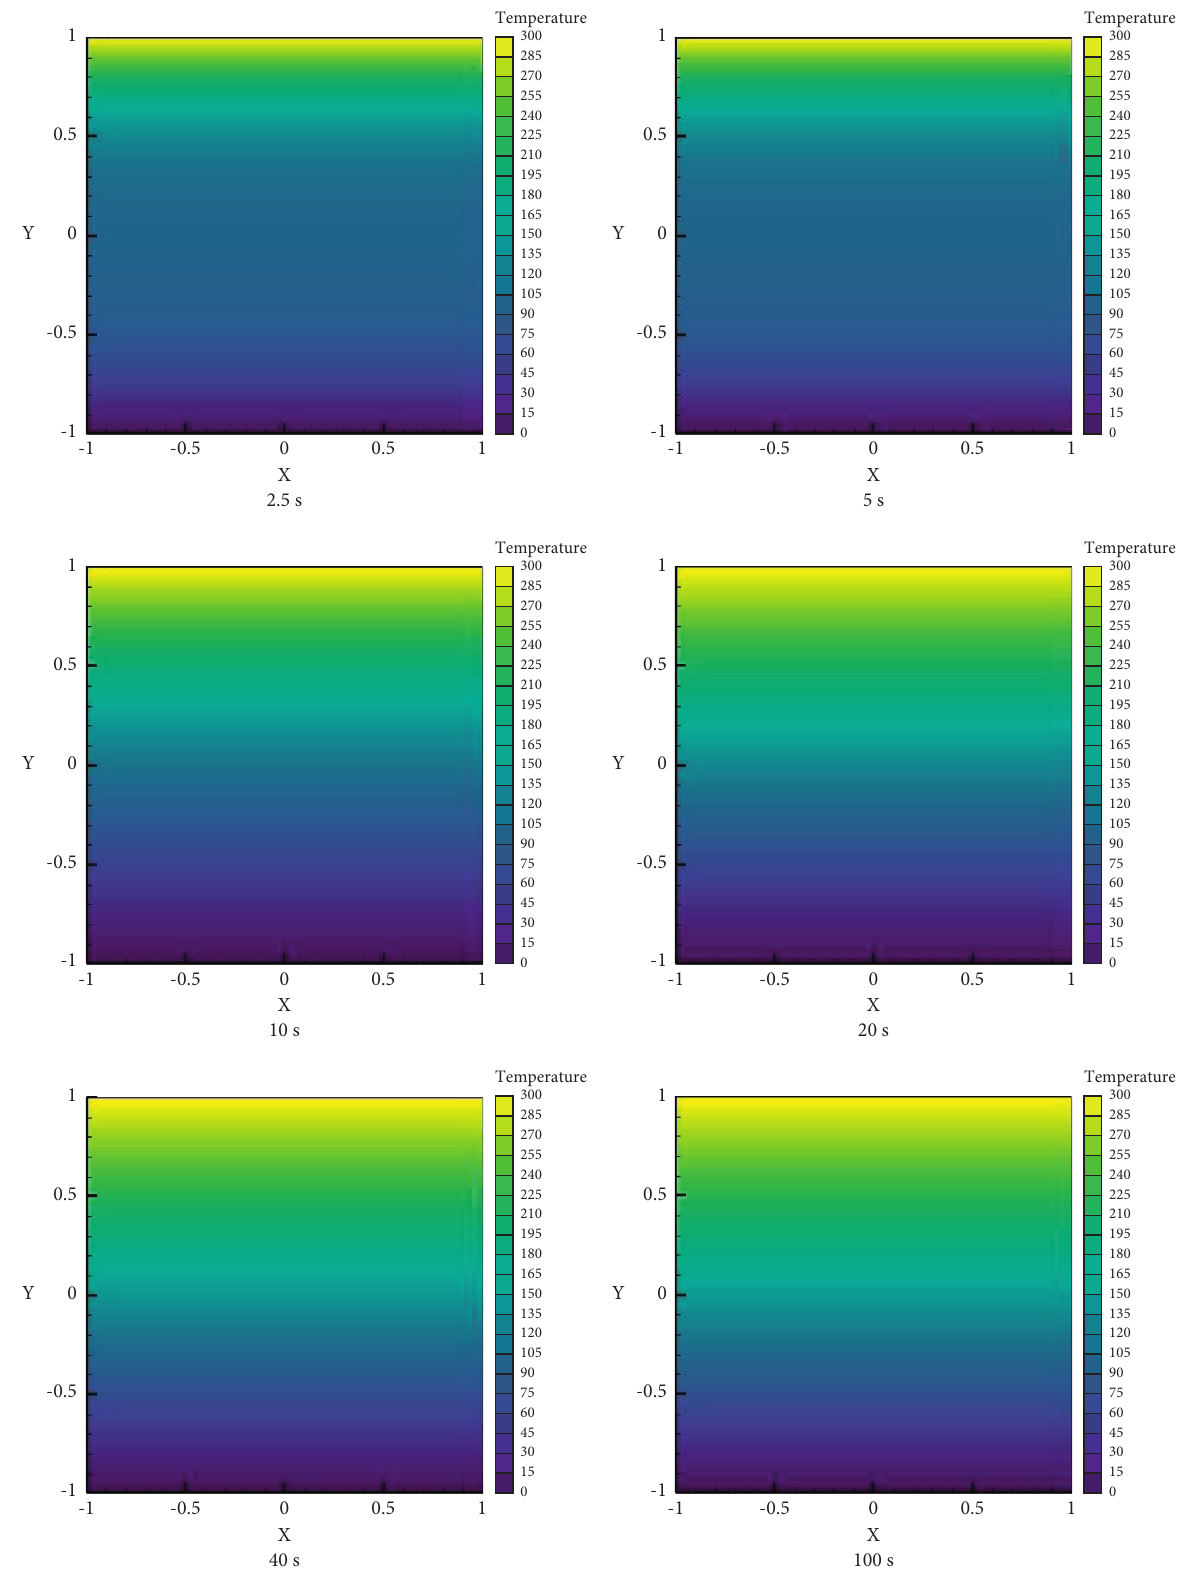
Figure 10: Temperature contours for time values of (a) 2.5, (b) 5. (c) 10, (d) 20, (e) 40, and (f) 100